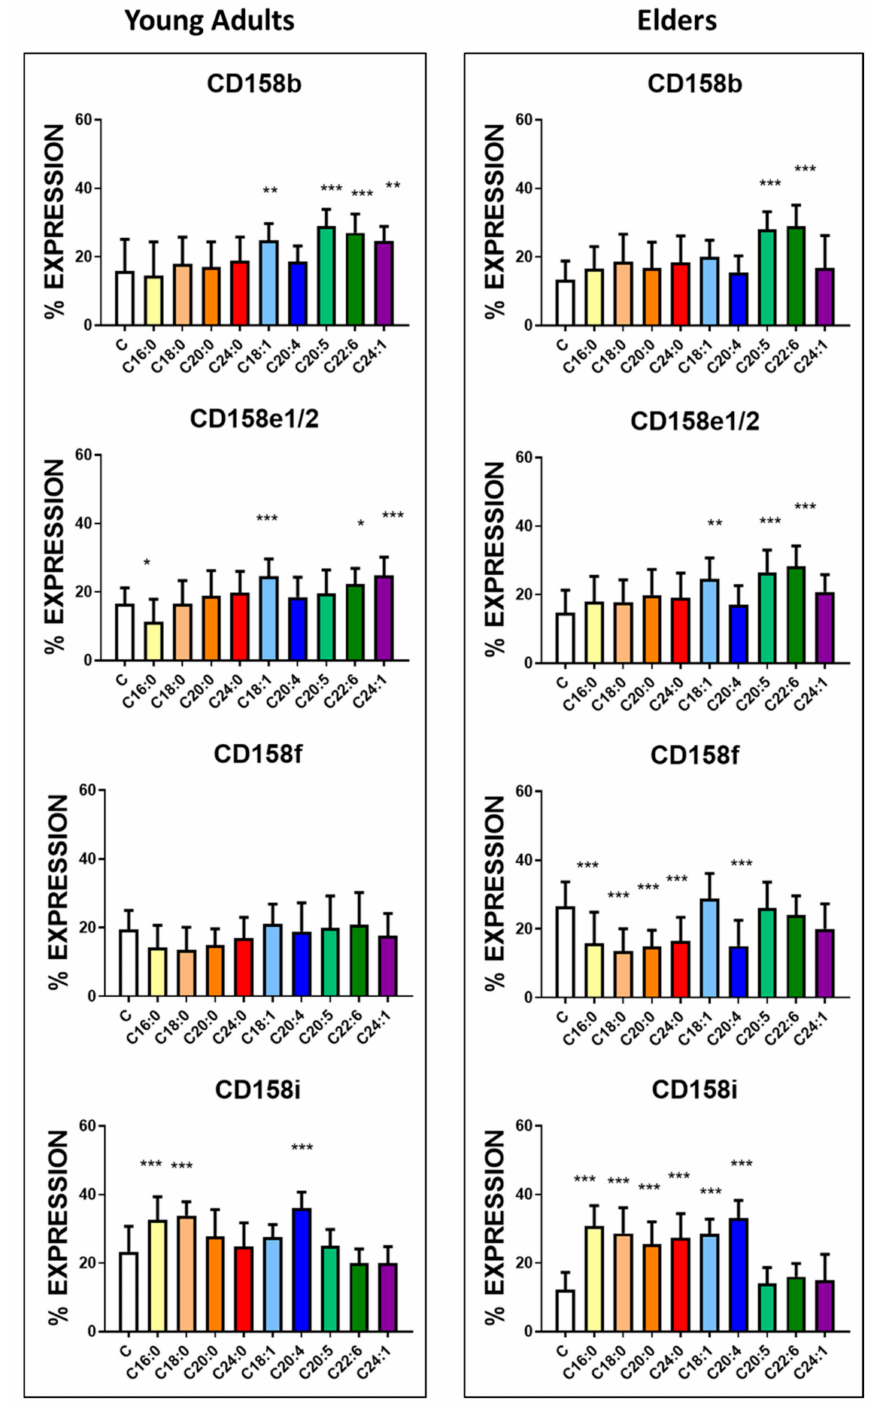
Figure 2. E ff ects of fatty acids on the expression of CD158 antigens in NK cells. The receptors are inhibitory except for CD158i. NK cells purified from the blood of the healthy young adults (23 ± 4 years old) and healthy elders (63 ± 5 years old) were treated with 10 µ g / mL concentration of the following fatty acids for 24 h. The expression of the receptors was assessed by flow cytometry. The results represent the percentage mean and SD for each group ( n = 30). Treatments were compared by one way ANOVA. Bonferroni significance post-test are represented. * p < 0.01, ** p < 0.001 and *** p < 0.0001. The mean channel fluorescent intensity (MFI) is represented in Supplementary Figure